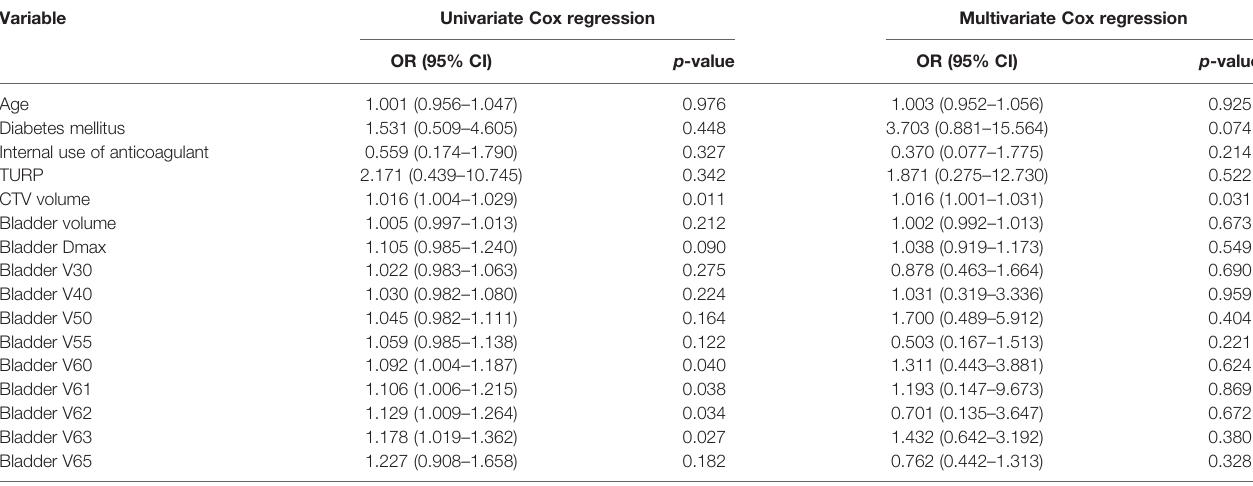
TABLE 3 | Univariate and multivariate clinical and DVH associations with acute GU toxicities ( ≥ grade 1).